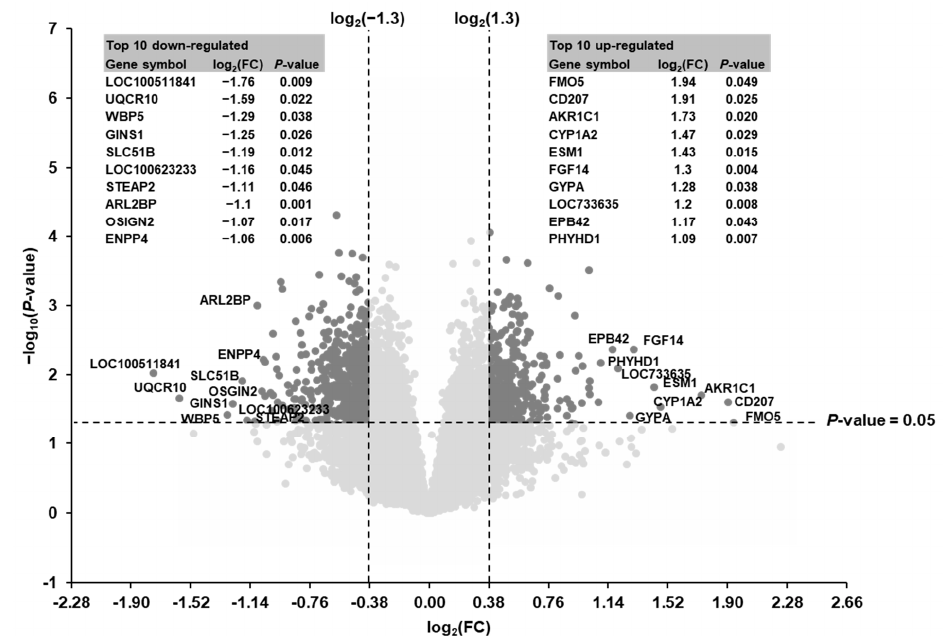
Figure 2. Volcano plot illustrating the differentially regulated transcripts in the liver of suckling piglets between the SINS high group and the SINS low group. The double filtering criteria are indicated by horizontal ( p -value < 0.05) and vertical (FC > 1.3 or FC < − 1.3) dashed lines. Transcripts in the upper left and the upper right corner represent the down-regulated and the up-regulated transcripts, respectively. The top 10 up- and down-regulated transcripts are indicated with their gene symbols and log2(FC) and p -values are presented in the tables in the left (down-regulated) and right (up-regulated).